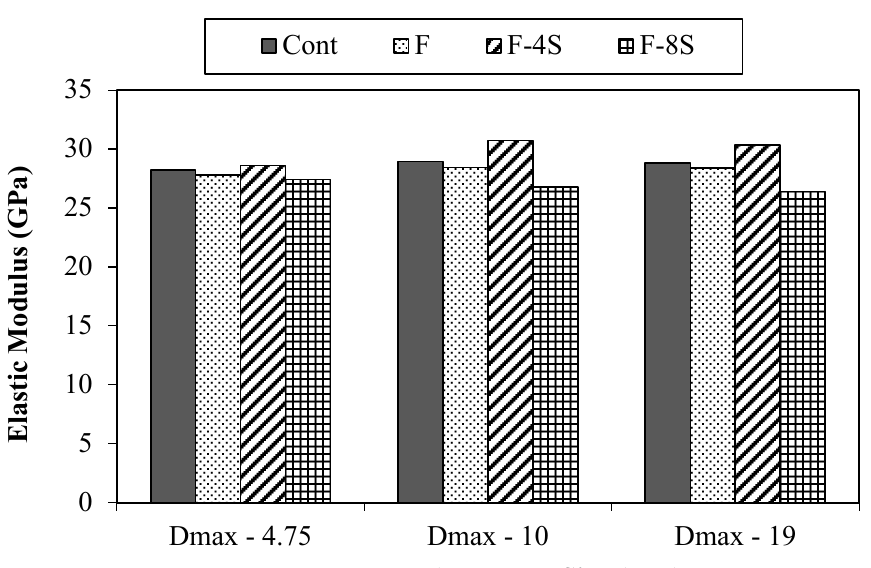
Figure 9. Elastic modulus results.